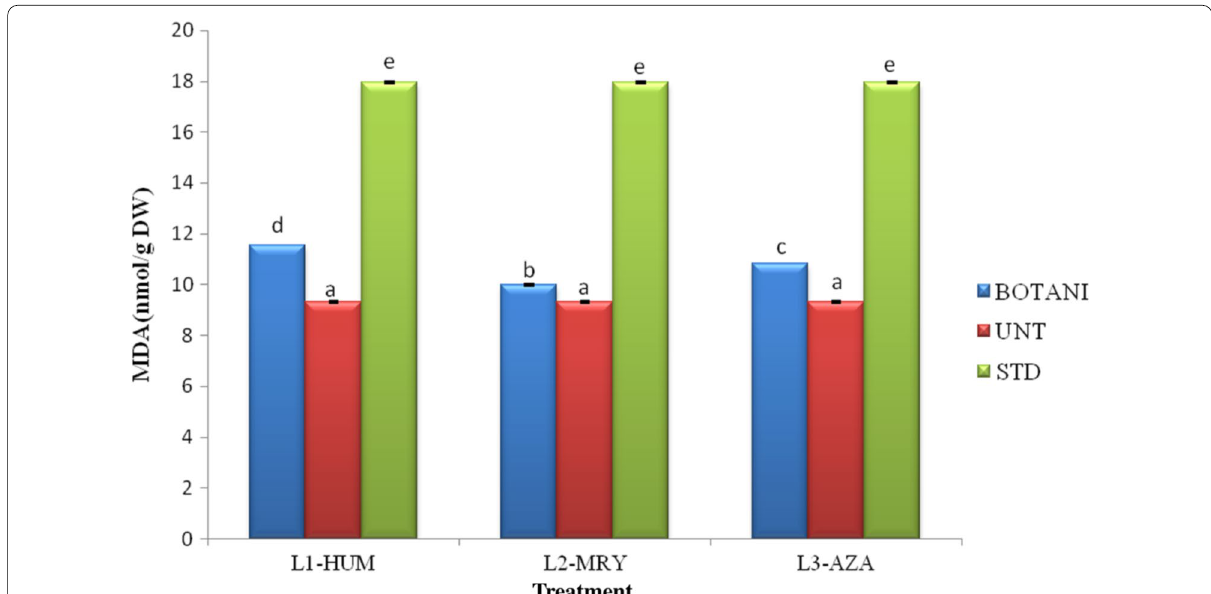
Botanical insecticides, L4-UNT LOT 4 = = LOT 2 (Myristicin), L3-AZA LOT 3 = =